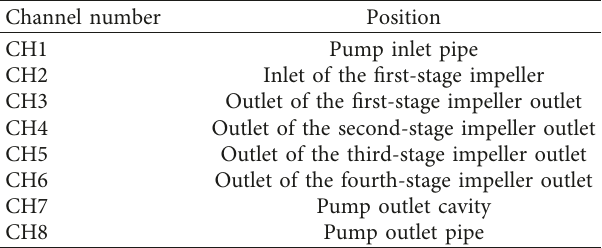
Table 1: Position of each monitoring point. Channel